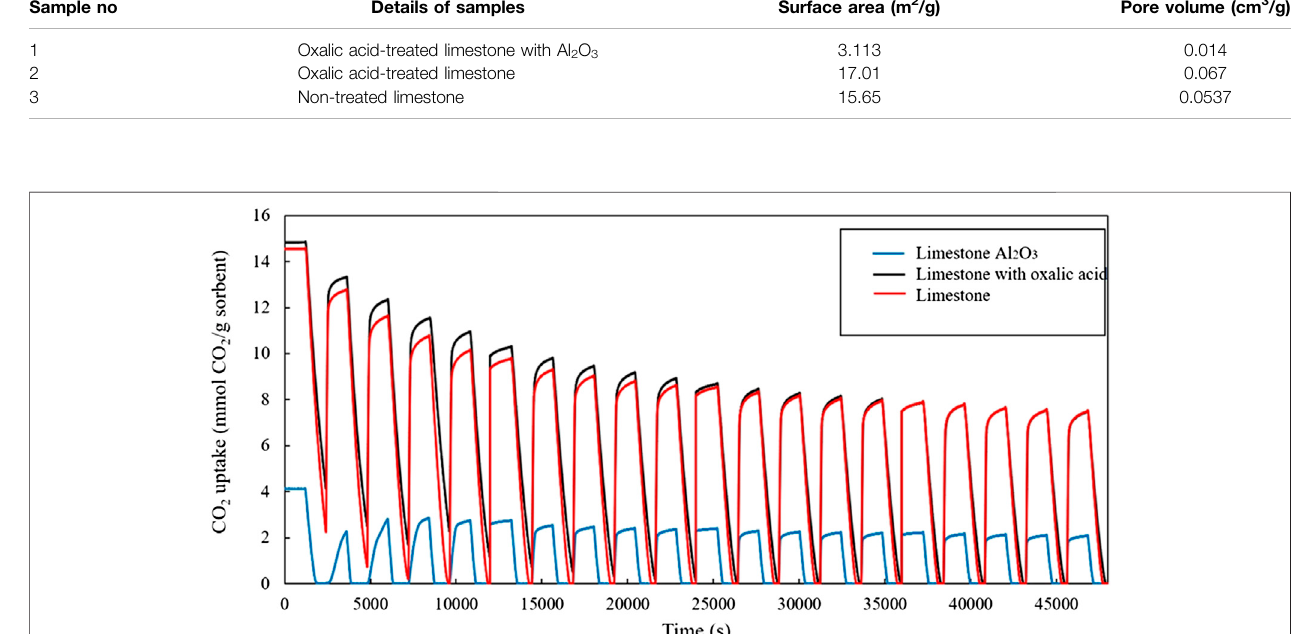
FIGURE 4 | CO 2 uptake of the sorbents during the isothermal TGA cycling experiments at 750 ° C, with 20 min carbonation and 20 min calcination in each cycle.